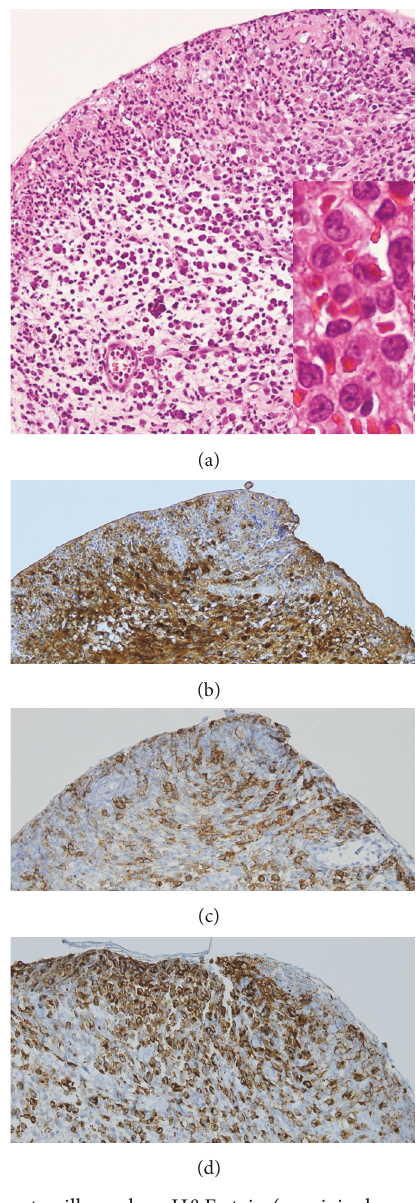
Figure 2: Pathology of the biopsied pretreatment axillary ulcer. H&E stain (a; original magnification × 200 with magnified photo showing LCH cells with folded coffee bean-like nucleus, × 400) and immunostaining of S100-positive (b), CD1a-positive (c), and CD207-positive (d) LCH cells (original magnification: ×